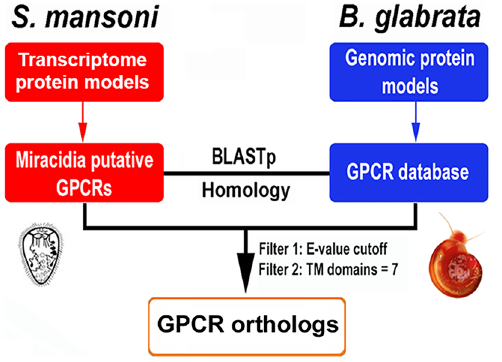
Figure 1. Workflow for identification of shared GPCRs mined from the B. glabrata genome and transcriptome of S. mansoni